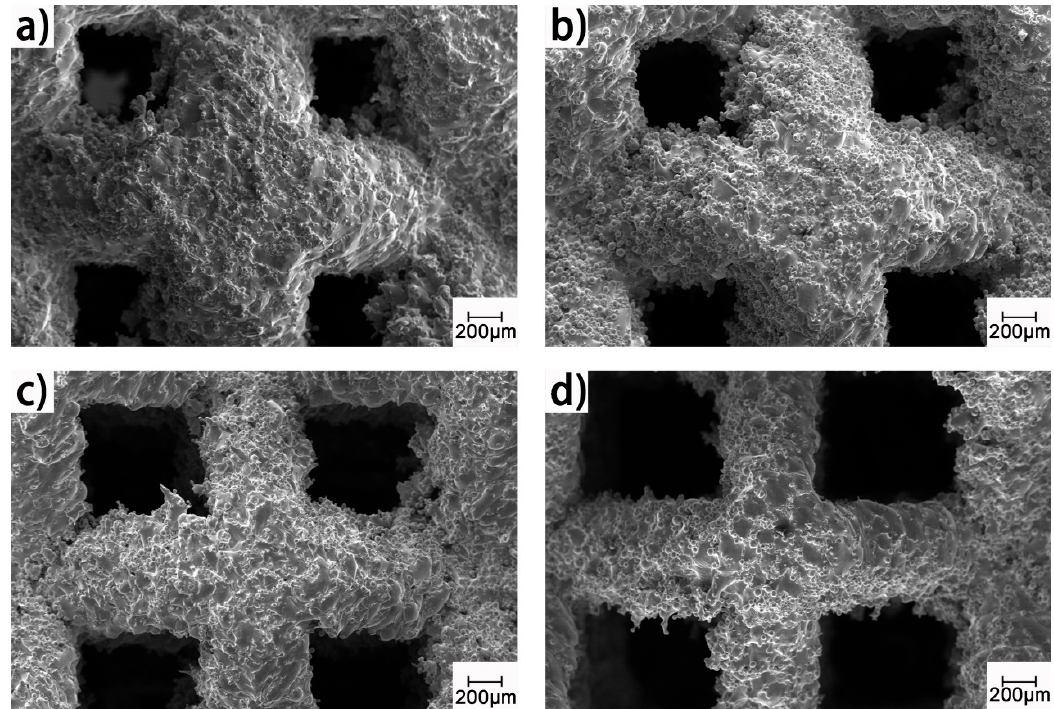
Figure 4. SEM images of the as-built porous samples with different strut diameters: ( a ) 780 μ m; ( b ) 680 μ m; ( c ) 580 μ m; ( d ) 480 μ m.